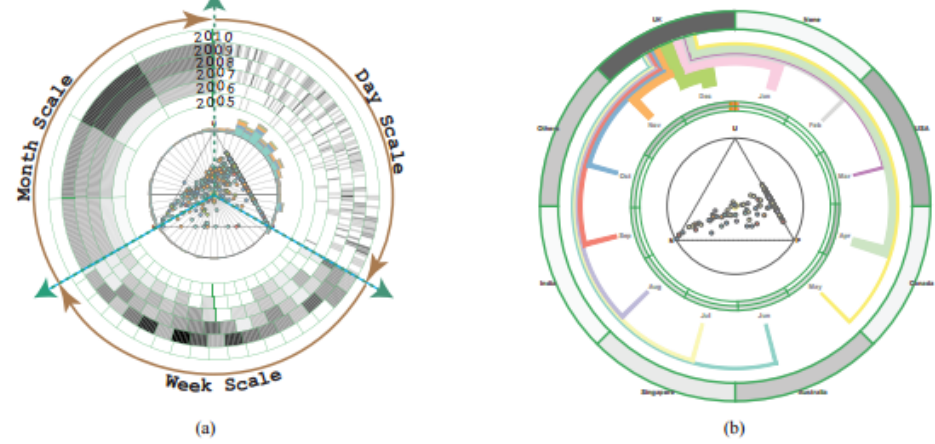
Figure 27. ( a ) The OpinionSeer temporal rings at different scales. Each layer represents a year and the colour depicts the feedback. ( b ) The reviewer location linked in with the time of year the review is made. The user selects the location from the outside ring to see the feedback from that country. Image courtesy of Wu et al.